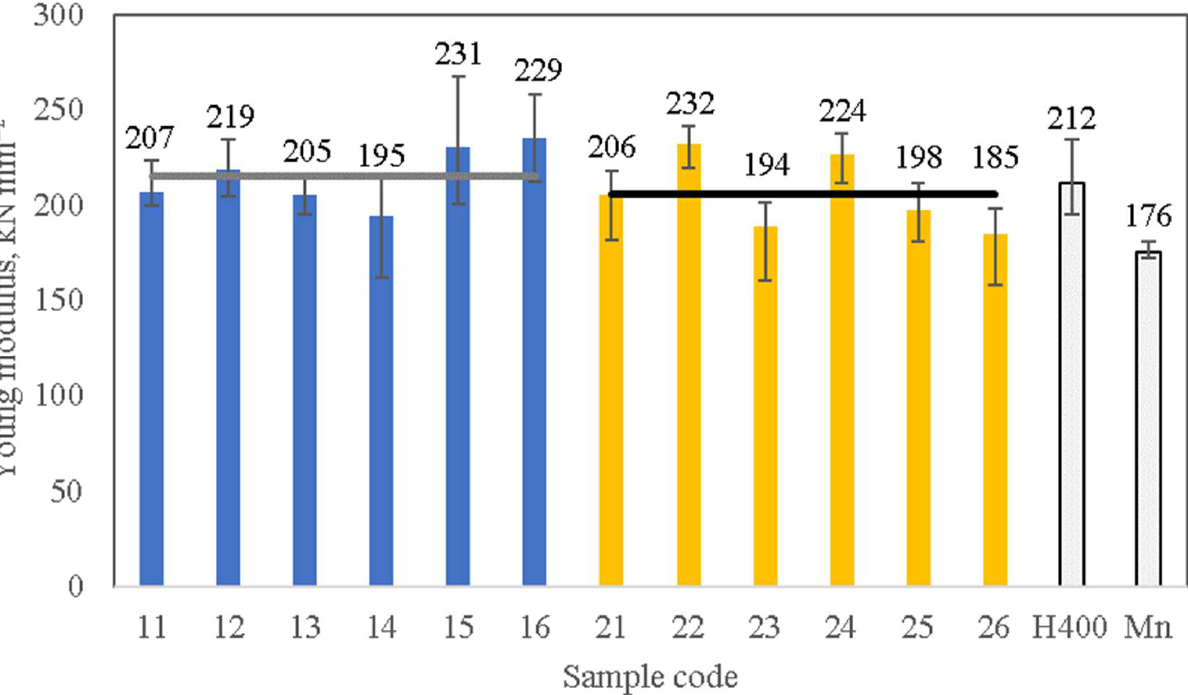
Figure 13. Young’s modulus of tested materials determined by instrumented indentation method. Lines indicate the average values of each group (group 11–16, 214; group 21–26, 206 kN · mm − 2 ). Color indicates the groups without (11–16), with (21–26) thermal treatment and reference materials (H400,